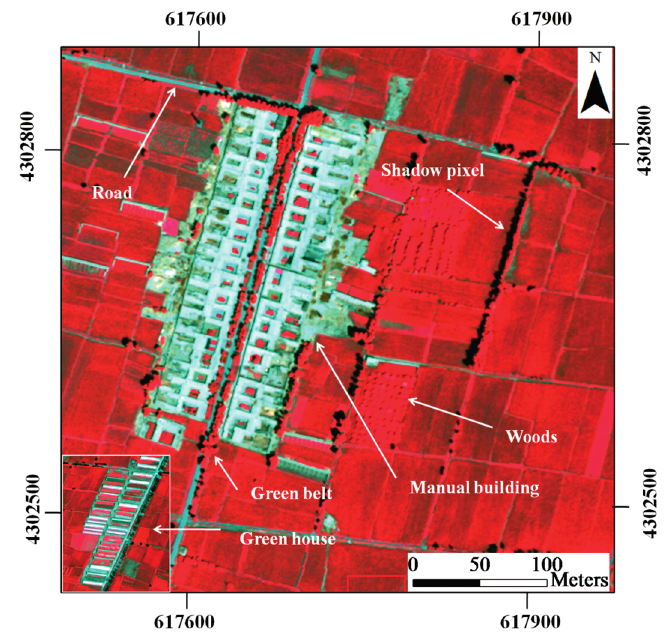
Figure 7. The distribution of disturbed pixels from the CASI data (red band: 855 nm, green band: 645 nm, and blue band: 552